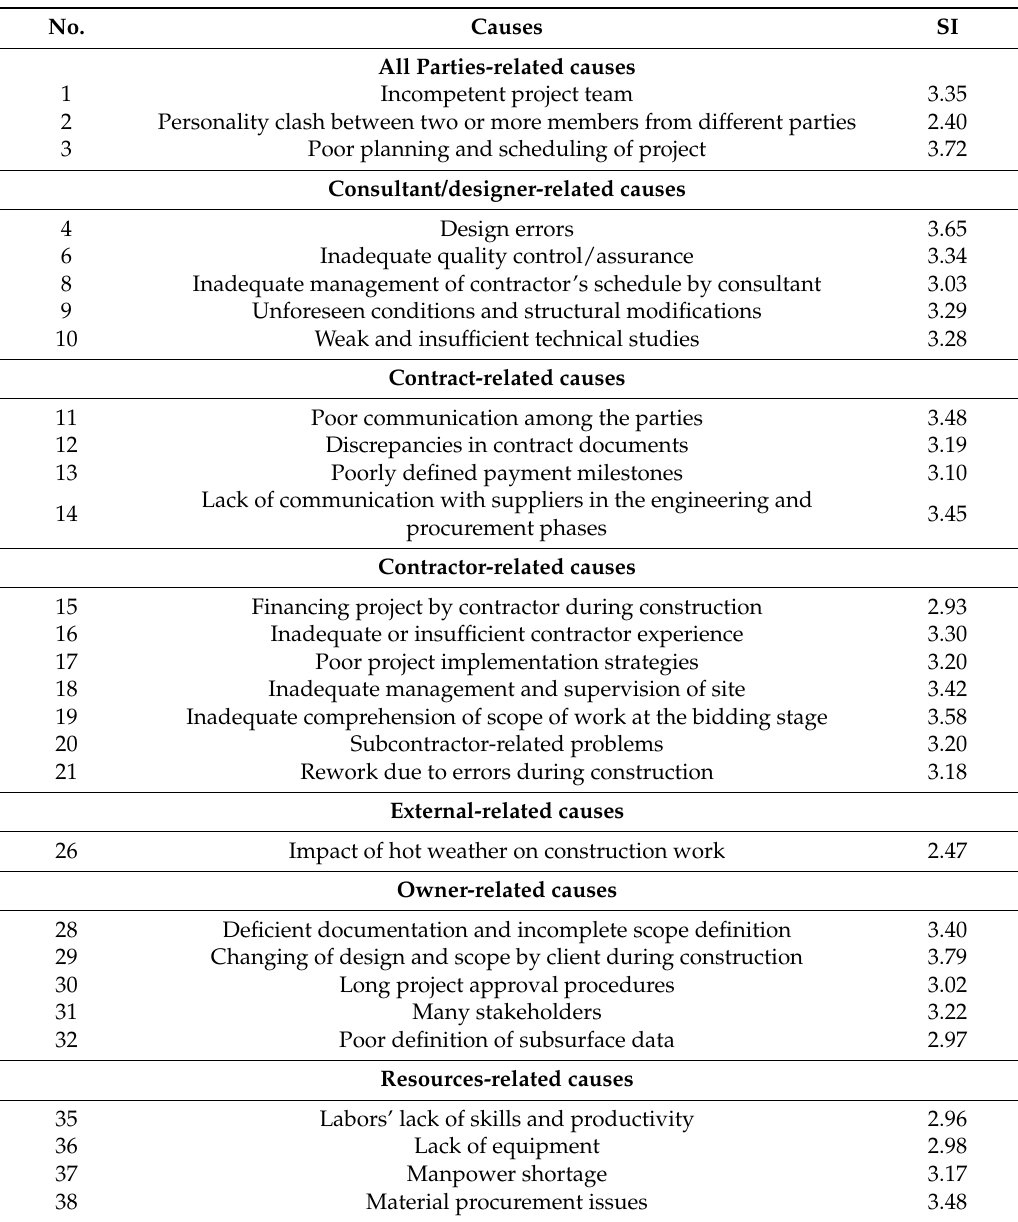
Table 3. Causes of time